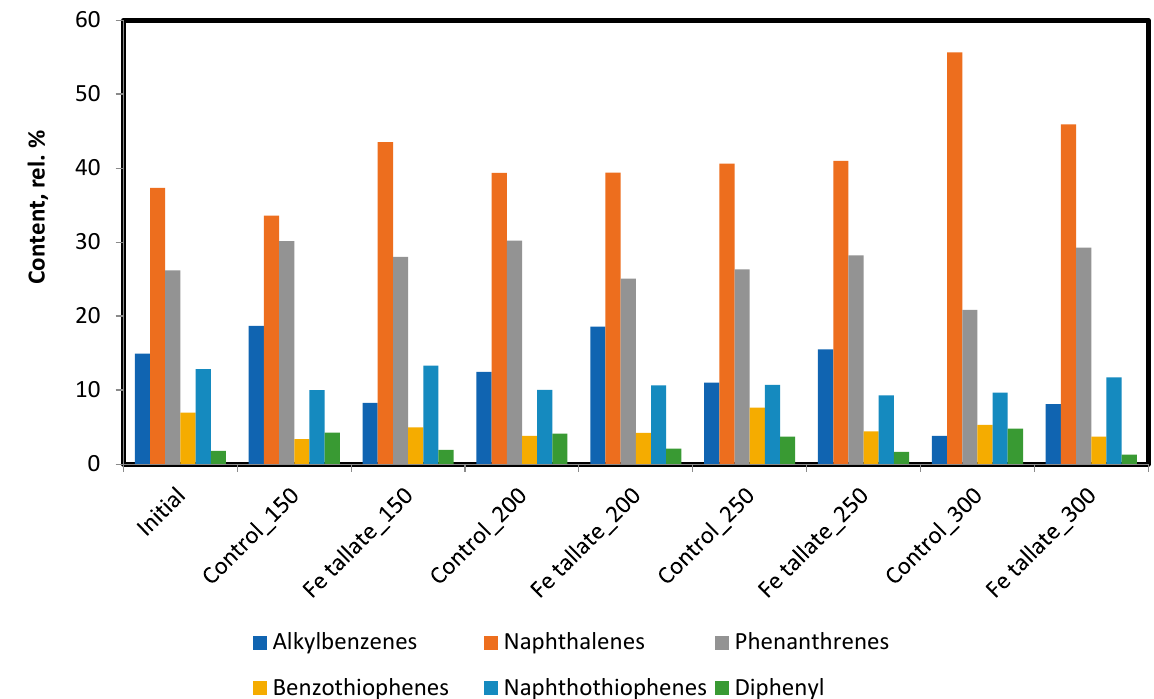
Figure 14. Relative content of identified compounds in the aromatic fraction. Table 1. Results of molecular mass measurements of oil